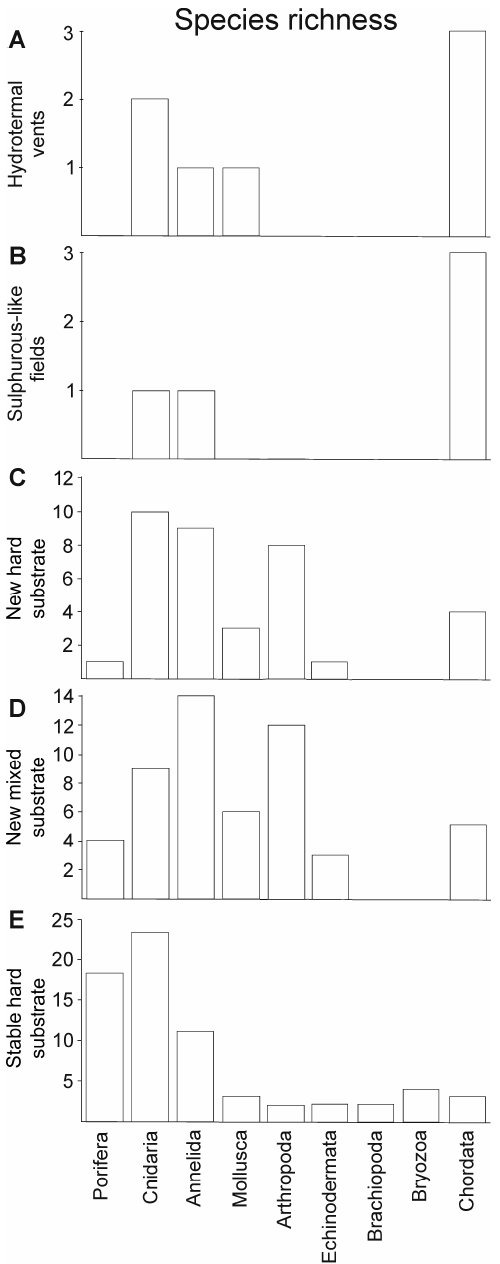
Figure 6. Species richness (number of species) in the different phyla identified in underwater images (ROV and VOR), as well as in the benthic dredges, within the different habitats at the Tagoro volcano complex ( A – D ) and at an undisturbed area ( E ).